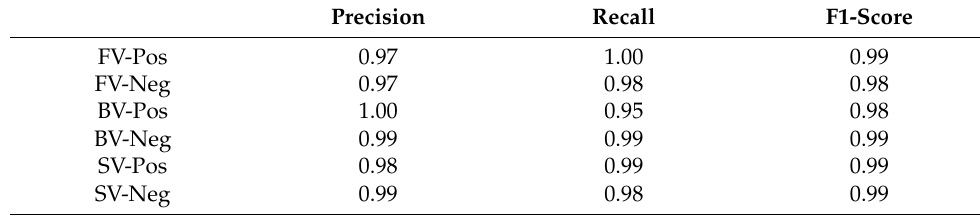
Table 17. The evaluation results on INRIA, ILIDS, and MSMT17 datasets. Table 18. Precision, recall, and F1-score for INRIA, ILIDS, and MSMT17 datasets.